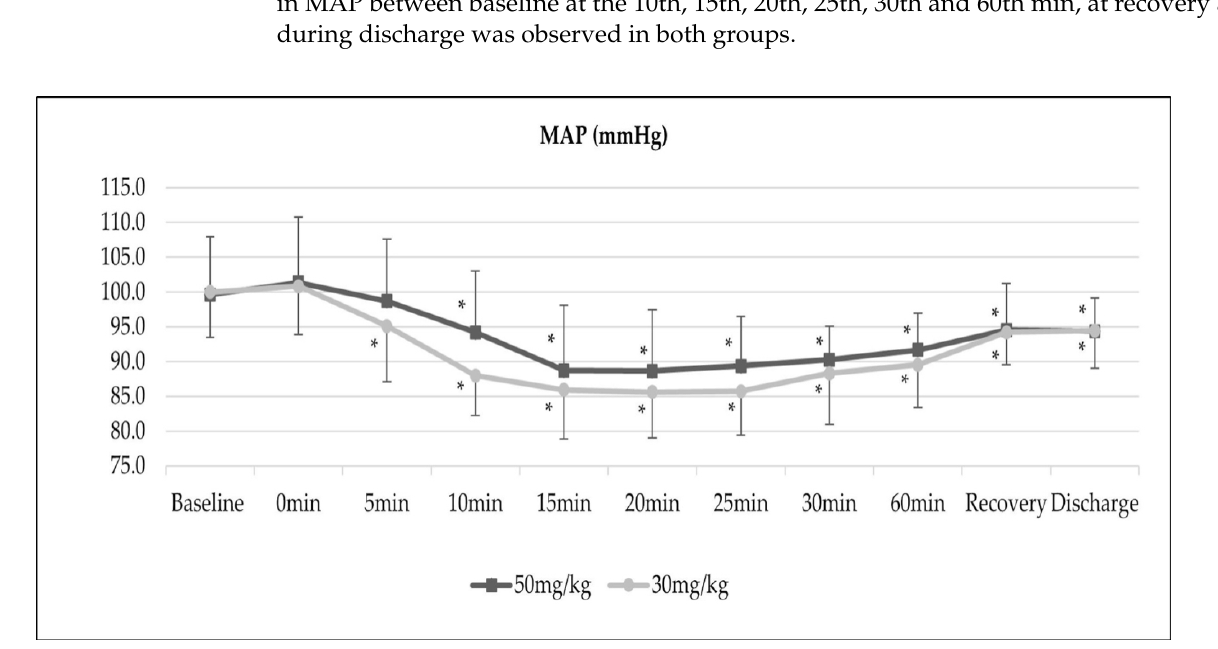
Figure 1. Trend of MAP, p = 0.008; * p < 0.05 (intragroup comparison with baseline MAP). The trend of SpO 2 over time was significantly lower in Group B compared to Group A ( p -value 0.04), as shown in Figure 2. Group A demonstrated a significant reduction in oxygen saturation at the 20th, 25th and 30th min compared to baseline ( p -value 0.02, 0.006 and 0.004, respectively). The trends of heart rate and core temperature were insignificant between both groups, as demonstrated in Figures 3 and